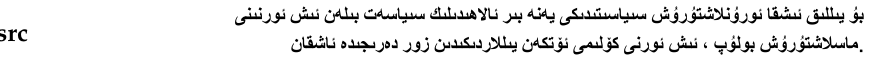
15 of 19 Figure 5. Translation results (RIBES score) for the hybrid framework. 4.5. Case Study According to the translation results as listed in Table 10, it can be seen that firstly, all the outputs including single systems and the system combination model guarantee the accuracy of the information transmission from the source to the target sentence and the faithfulness of the source sentence. Secondly, the translation hypothesis of the SMT model is slightly less coherent than that of the NMT. Thirdly, the four stronger transformer mod- els either mistranslated the keyword “ 规模 (Scale)” to “ 面积 (Area)” or failed to translate the key phrase “ ناقشائ ەدىجىرەد روز (Far more than) ”. In short, no single system can obtain promising translation results. The system combination model based on the multi-source method (MUSC) can obtain the correct keyword “ 规模 (Scale)” from multiple translation hypotheses but cannot capture the relationship between “ 政策 (Policy)” and “ 岗位